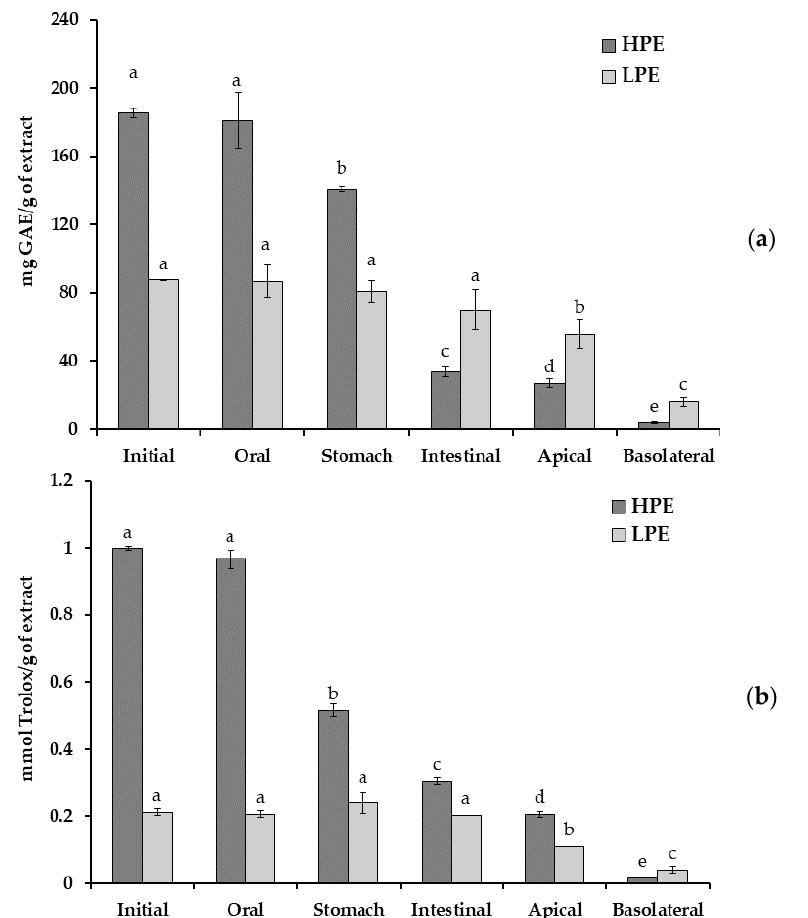
Figure 1. TPC ( a ) and antioxidant activity ( b ) of HPE and LPE during the simulated digestion and transepithelial transport on the Caco-2 absorption process. Data represent mean ± SD ( n = 9). a – e Different letters indicate significant differences during the digestion process of each extract using the LSD test ( p < 0.05).